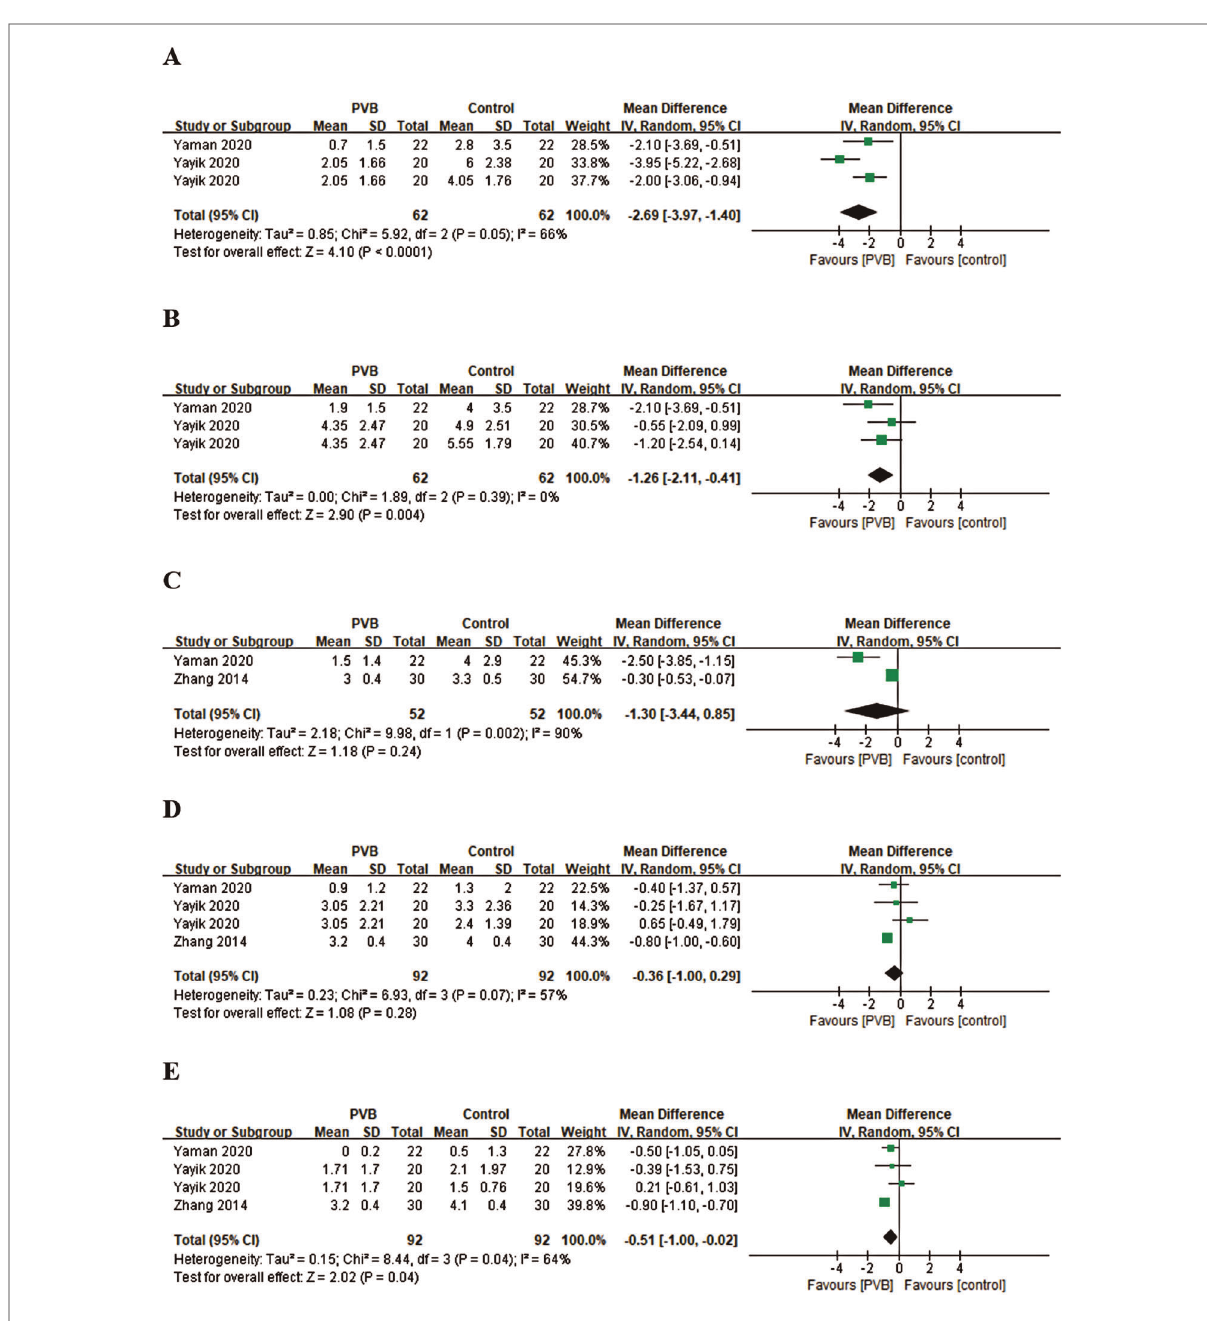
FIGURE 5 Forest plot of pain scores at movement at ( A ) 1 h, ( B ) 4 h, ( C ) 6 h, ( D ) 12 h, and ( E ) 24 h timepoints after